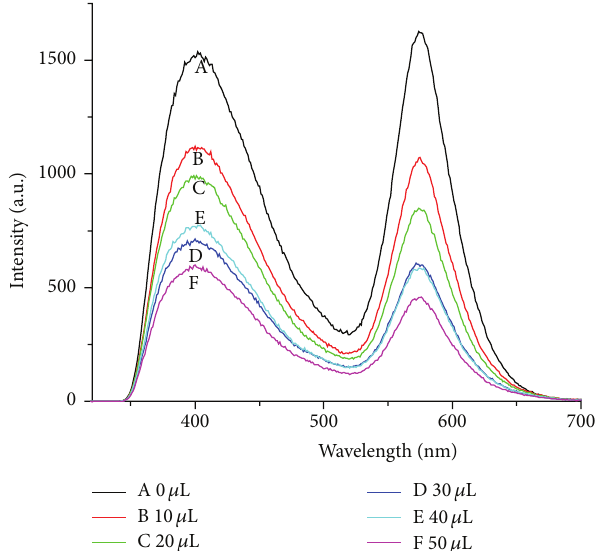
Figure 10: Fluorescence emission spectra of HA-ZnS:Mn 2+ QDs system. The HA concentration was fixed at 1.8315 × 10 −4 M and the concentration of ZnS:Mn 2+ QDs (8.0143 × 10 −3 M) increased from 0 𝜇 L to 50 𝜇 L, obtained using an excitation wavelength of